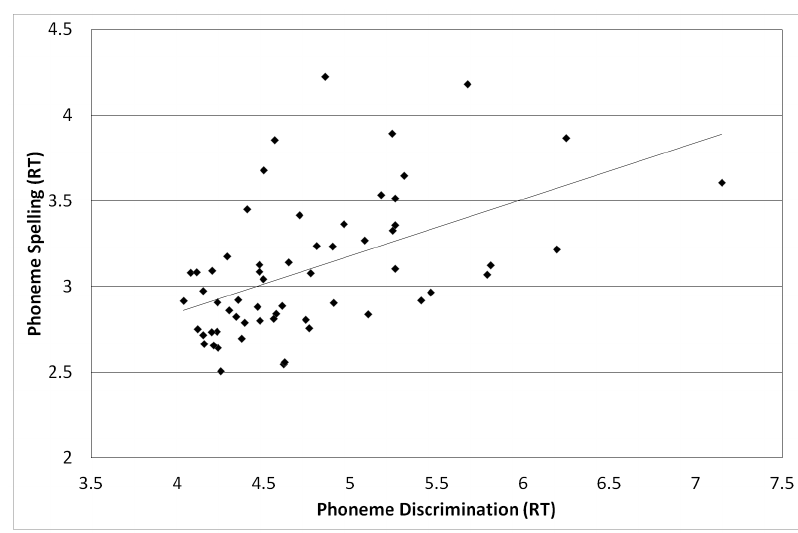
Figure 3. Correlation between phoneme discrimination and phoneme spelling, r (59)= .52, p , .001.